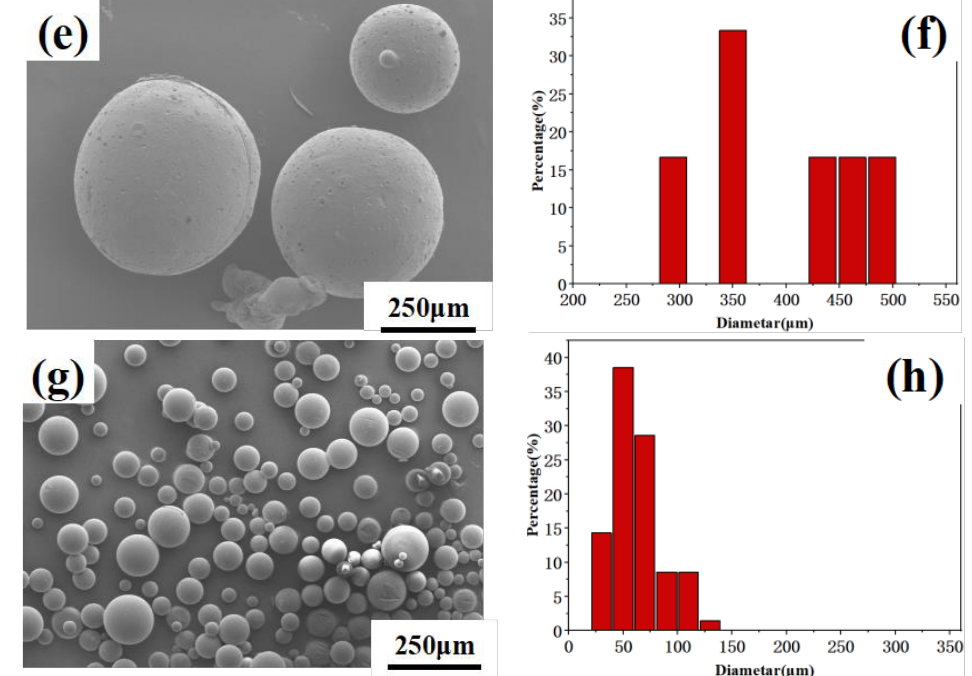
Figure 2. SEM image of ( a ) PS, ( c ) EGR/PS, ( e ) OMMT/EGR/PS and ( g ) PTFE/PS; size distribution of ( b )PS, ( d ) EGR/PS, ( f ) OMMT/EGR/PS, and ( h ) PTFE/PS.